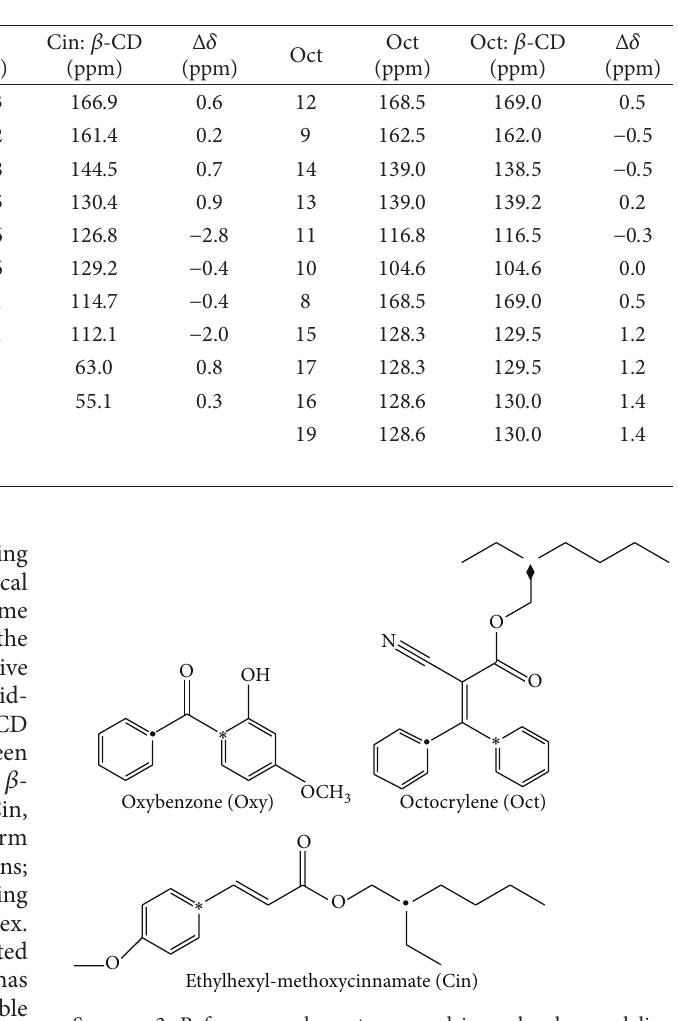
Table 2: 13 C chemical shifts of pure sunscreen agents (Oxy, Cin, and Oct), their inclusion complex with 𝛽 -CD, and the differences between the free sunscreens and the inclusion